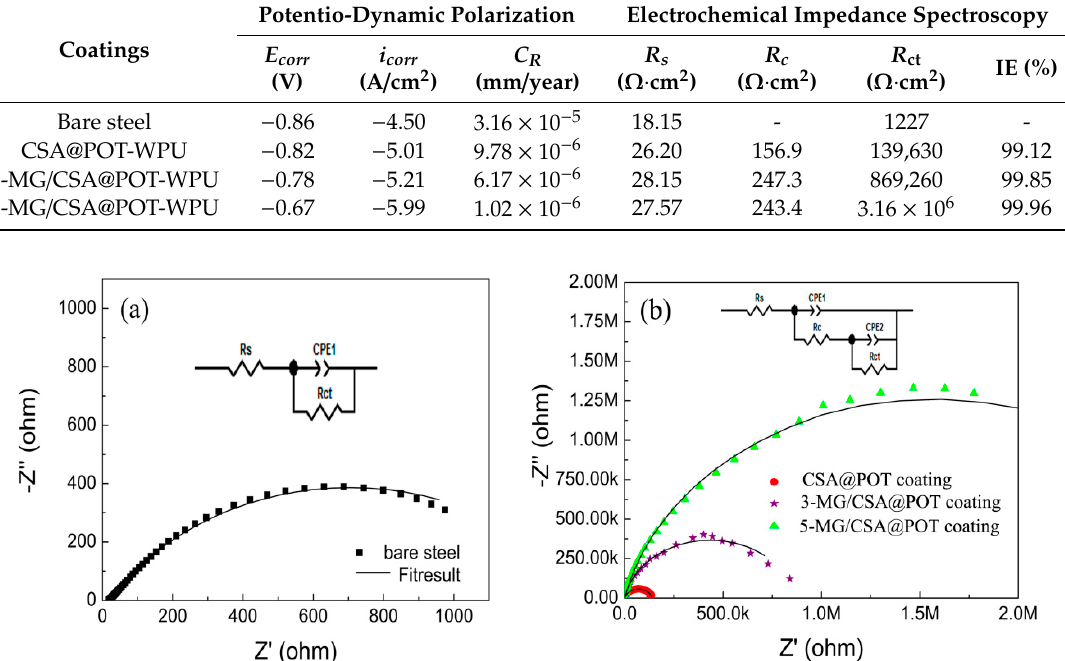
Table 1. Parameters for potentio-dynamic polarization and electrochemical impedance spectroscopy in a 3.5% NaCl solution.